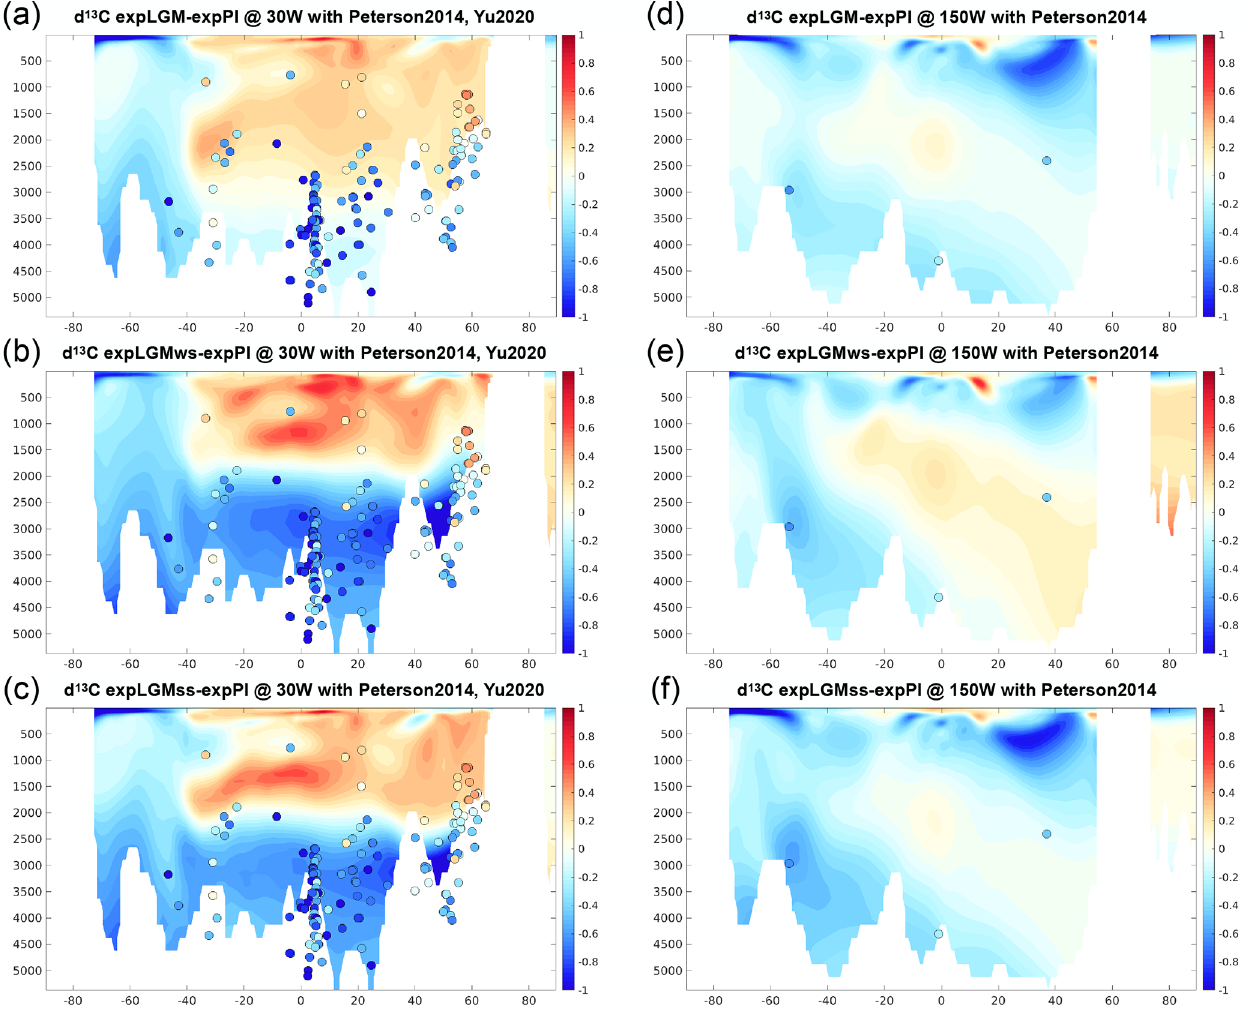
Figure 5. Meridional sections in the Atlantic ( a–c ; at 30 ◦ W) and in the Pacific ( d–f ; at 150 ◦ W) of the simulated δ 13 C of DIC in the LGM experiments (‰): expLGM (a, d) , expLGMws (b, e) , and expLGMss (c, f) . The differences between each LGM experiment and expPI are shown. The average states of the last 50 years are shown. The dots indicate the reconstructions by Peterson et al. (2014) and Yu et al.